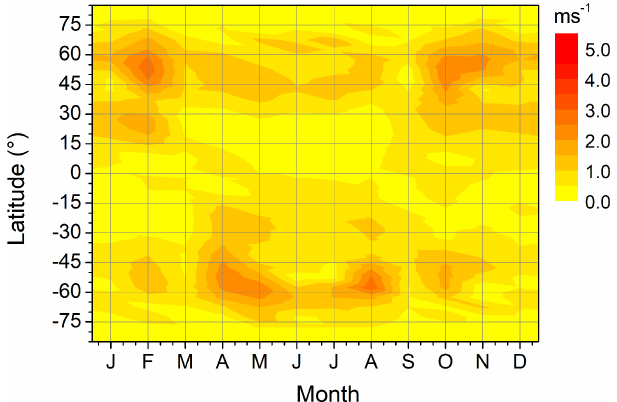
Figure A2. As in Fig. A1, but at 106 . 6km altitude.